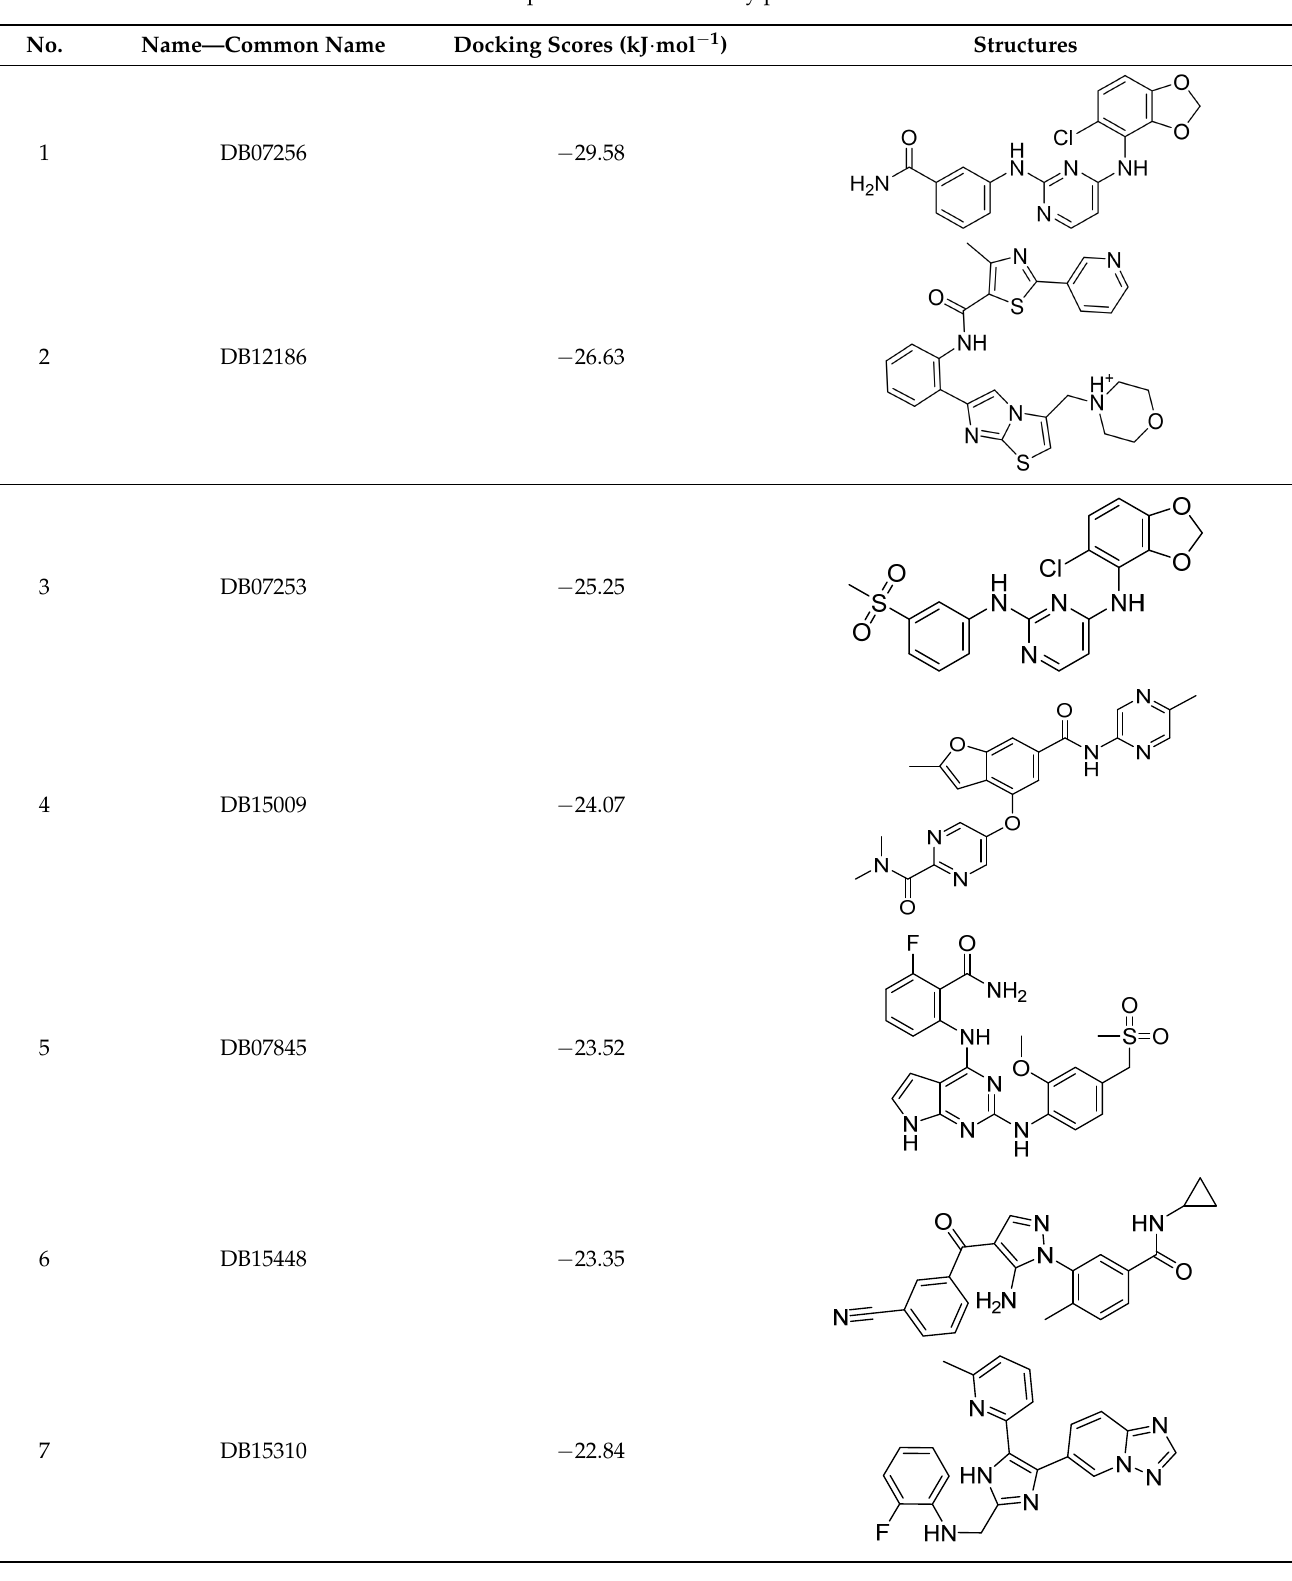
14 of 26 Figure 15 . Screening scheme of ABCG2 inhibitors . Based on docking score values, selected compounds with inhibitory potential for ABCG2 are listed in Table 8. Among the compounds selected from DrugBank, there were chemicals containing pyrimidine derivative such as 1, 3, 5, tetrahydro-β-carbolin frame derivative as number 10 or bisphenyl frame as substance 9. Among the